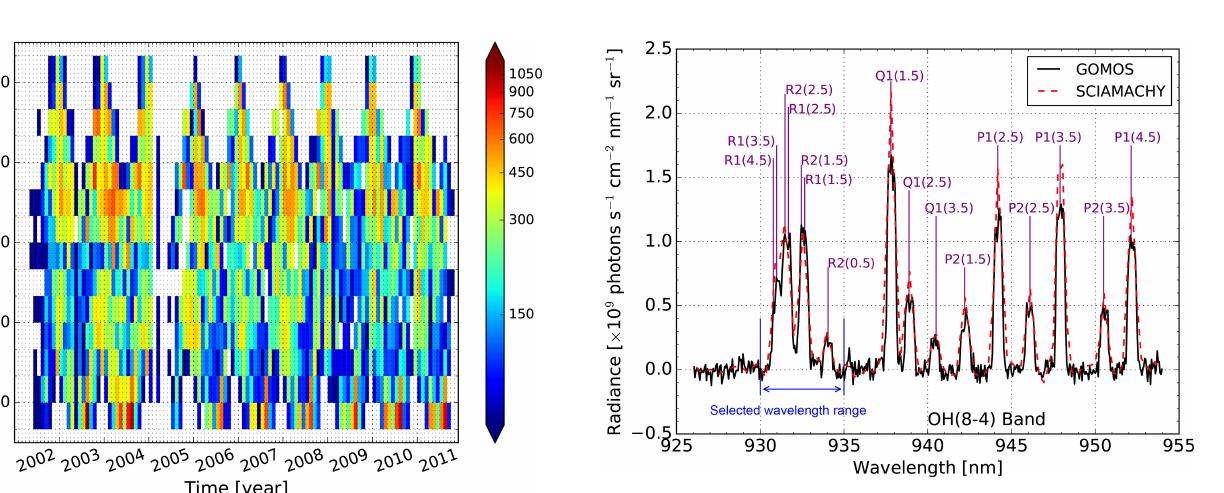
Figure 2. Latitudinal distribution of resampled GOMOS data avail- able from 2002 to 2012. Color coding indicates the number of se- lected profiles for each monthly and zonally averaged 10 ◦ latitude bin.